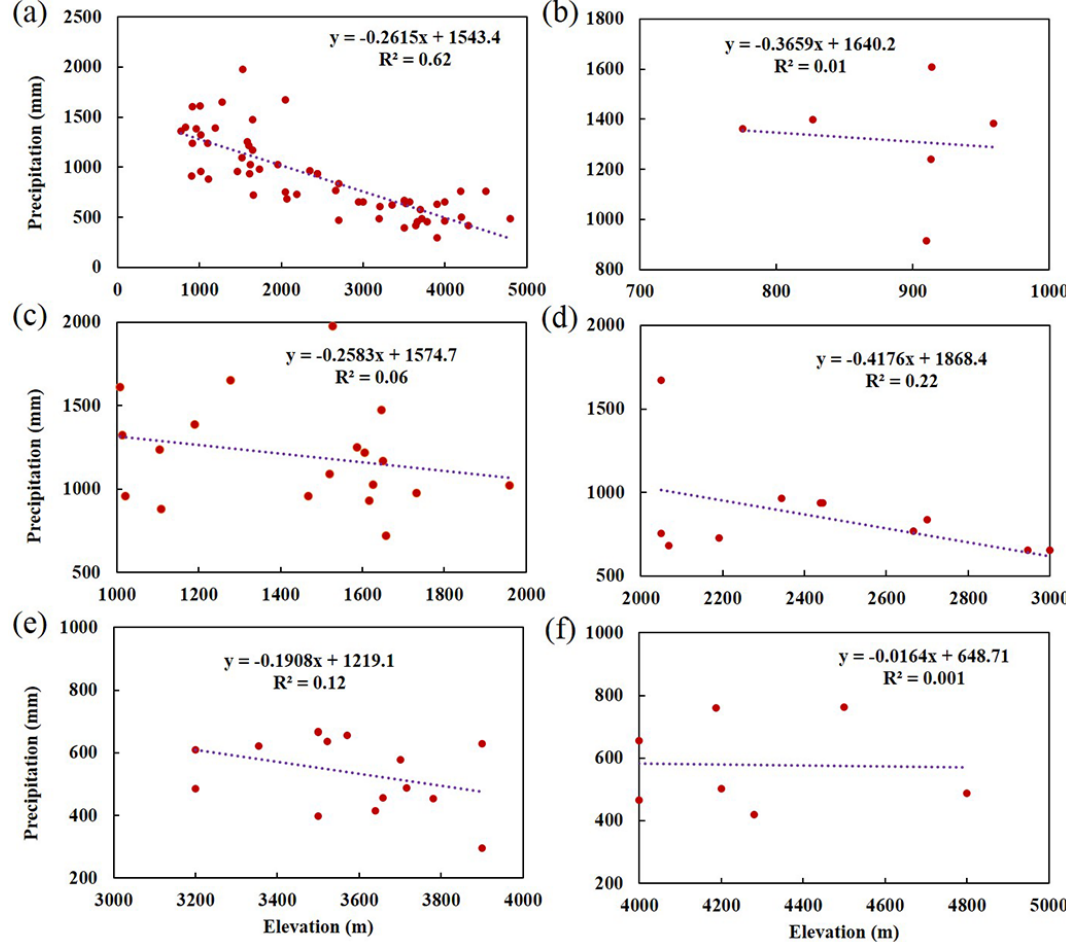
Figure 6. The relationship between mean annual precipitation and elevation at different elevation bands: (a) whole elevation bands; (b) ele- vation band: <1000m; (c) band: 1000–2000m; (d) band: 2000–3000m; (e) band: 3000–4000m; (f) band: